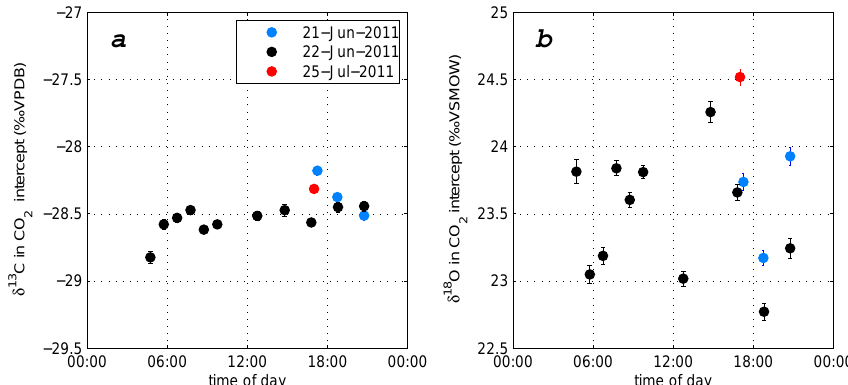
Fig. 3. Intercepts of Keeling plots for 13 C in CO 2 (a) and 18 O in CO 2 (b) for groups of entrance-exit flasks, plotted versus time of day. Different colours indicate different sampling dates. The error bars show the error of the